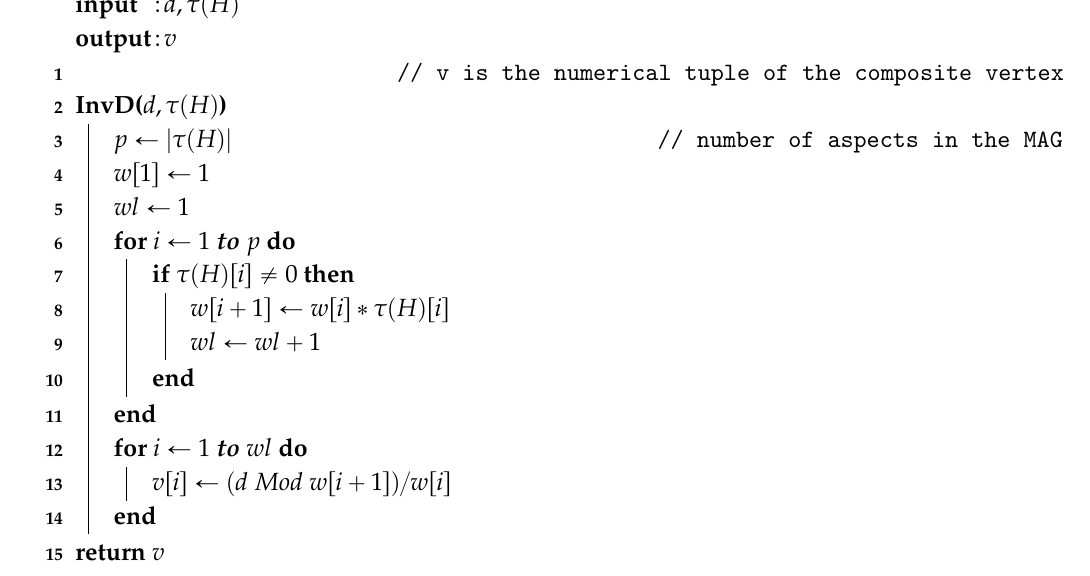
Algorithm 4: Determination of the composite vertex from its numerical